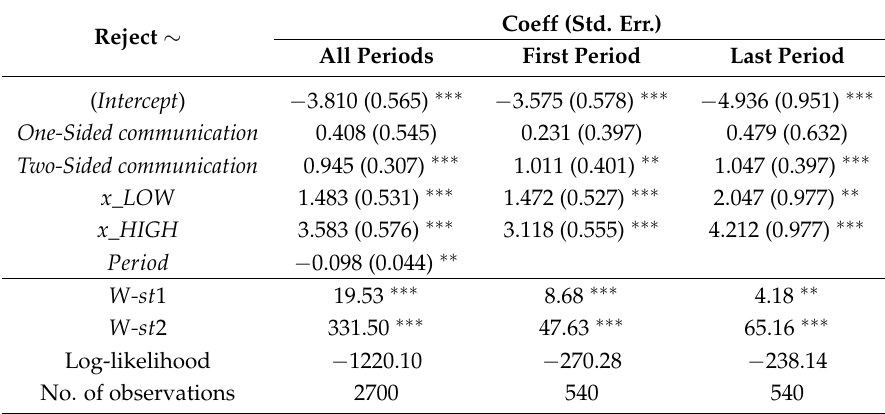
Table 4. Analysis of Responder Choices (GLLAMM: